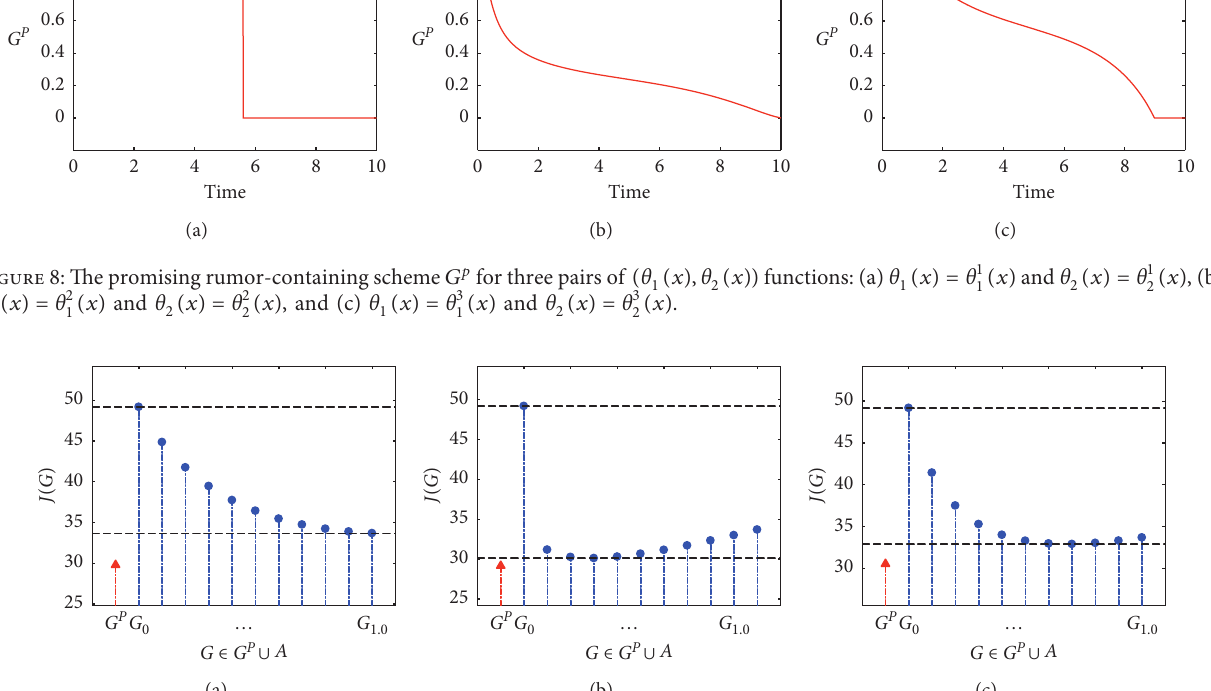
Figure 9: A comparison between the three promising controls G P in Figure 6 and the set of static controls A in terms of total